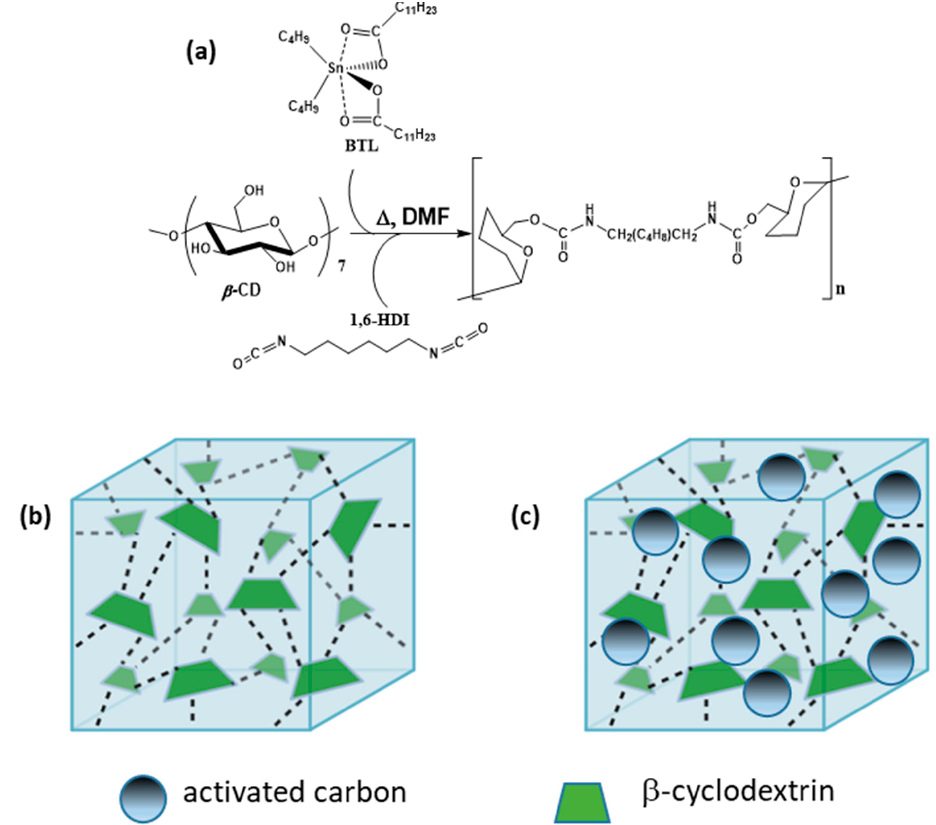
Figure 1. Representation of ( a ) synthesis route of poly( β -cyclodextrin) (PCD), ( b ) schematic structure of PCD and ( c ) schematic representation of PCD/AC matrix. Cyclodextrin (CD) and activated carbon (AC) structures are not at the same scale.